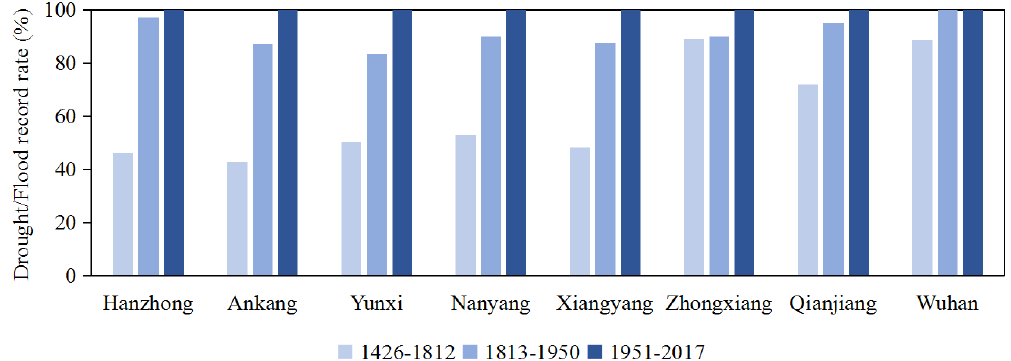
Figure 2. Proportion of drought and flood records in different periods at various sites.